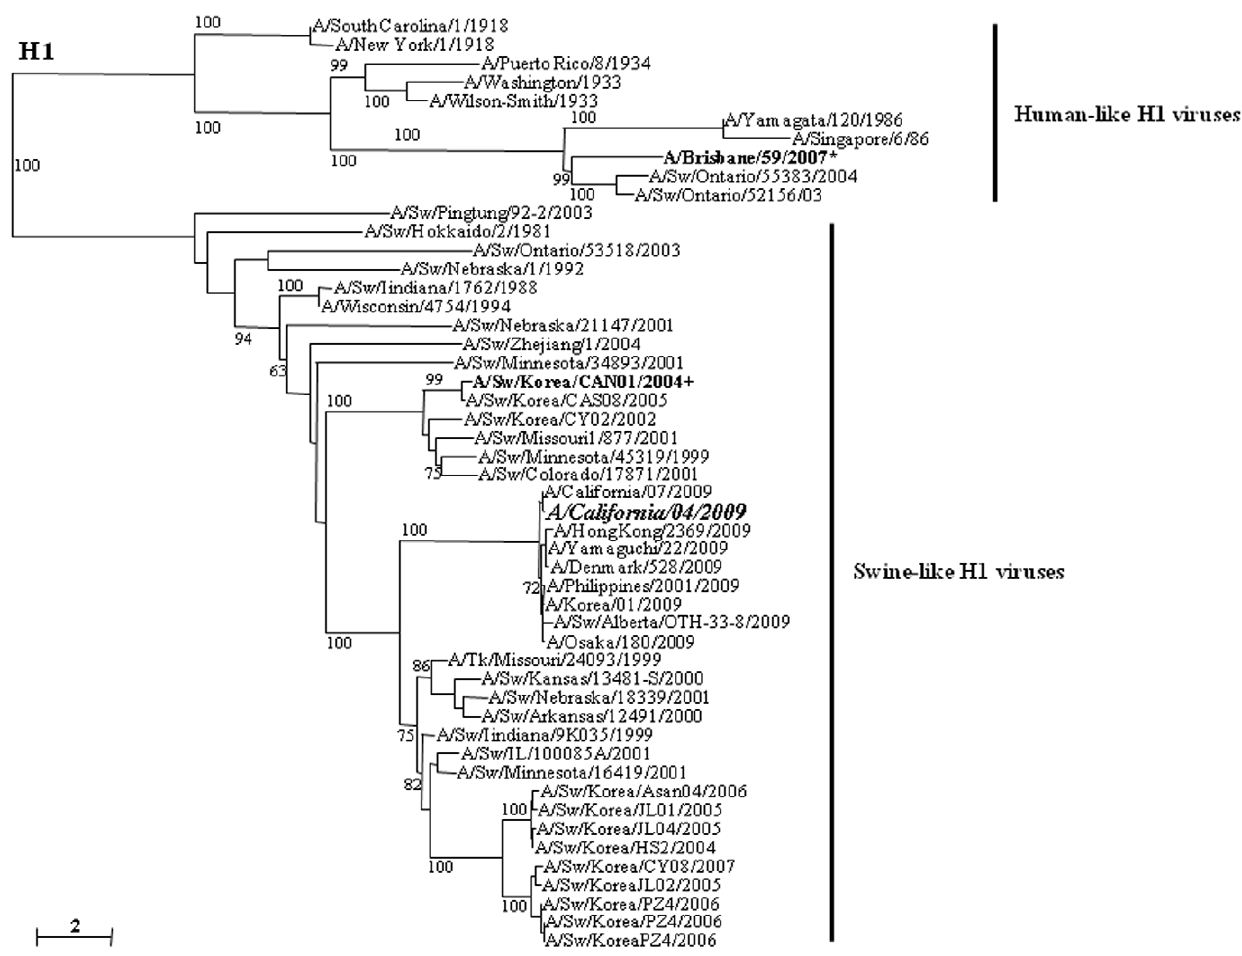
Figure 1. Alignment of the HA1 portion of the HA molecule of H1 influenza viruses. The amino acid sequences were aligned using Clustal_X [34,35], and the phylogenetic tree was generated by the neighbor-joining method using the tree drawing program NJ plot [36]. The scale represents the number of substitutions per nucleotide. Branch labels record the stability of the branches over 100 bootstrap replicates. Only bootstrap values $ 60% was shown in each tree. The A/California/04/2009 virus shares about 70% and 88.4% amino acid sequence homology with the seasonal human (A/Brisbane/59/2007*) and Korean swine (A/Swine/Korea/CAN01/2004 + ) H1N1 viruses, respectively.